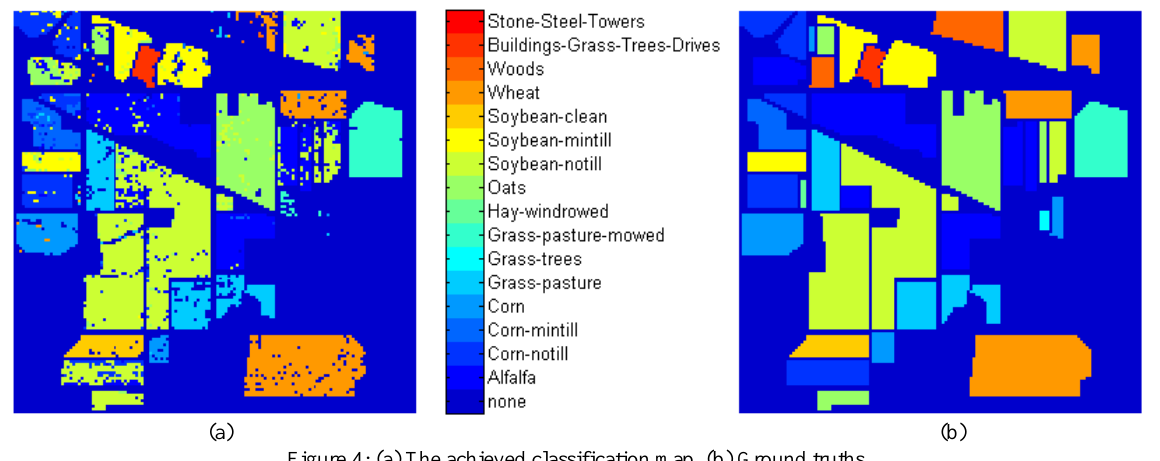
Figure 4: (a) The achieved classification map, (b) Ground truths.